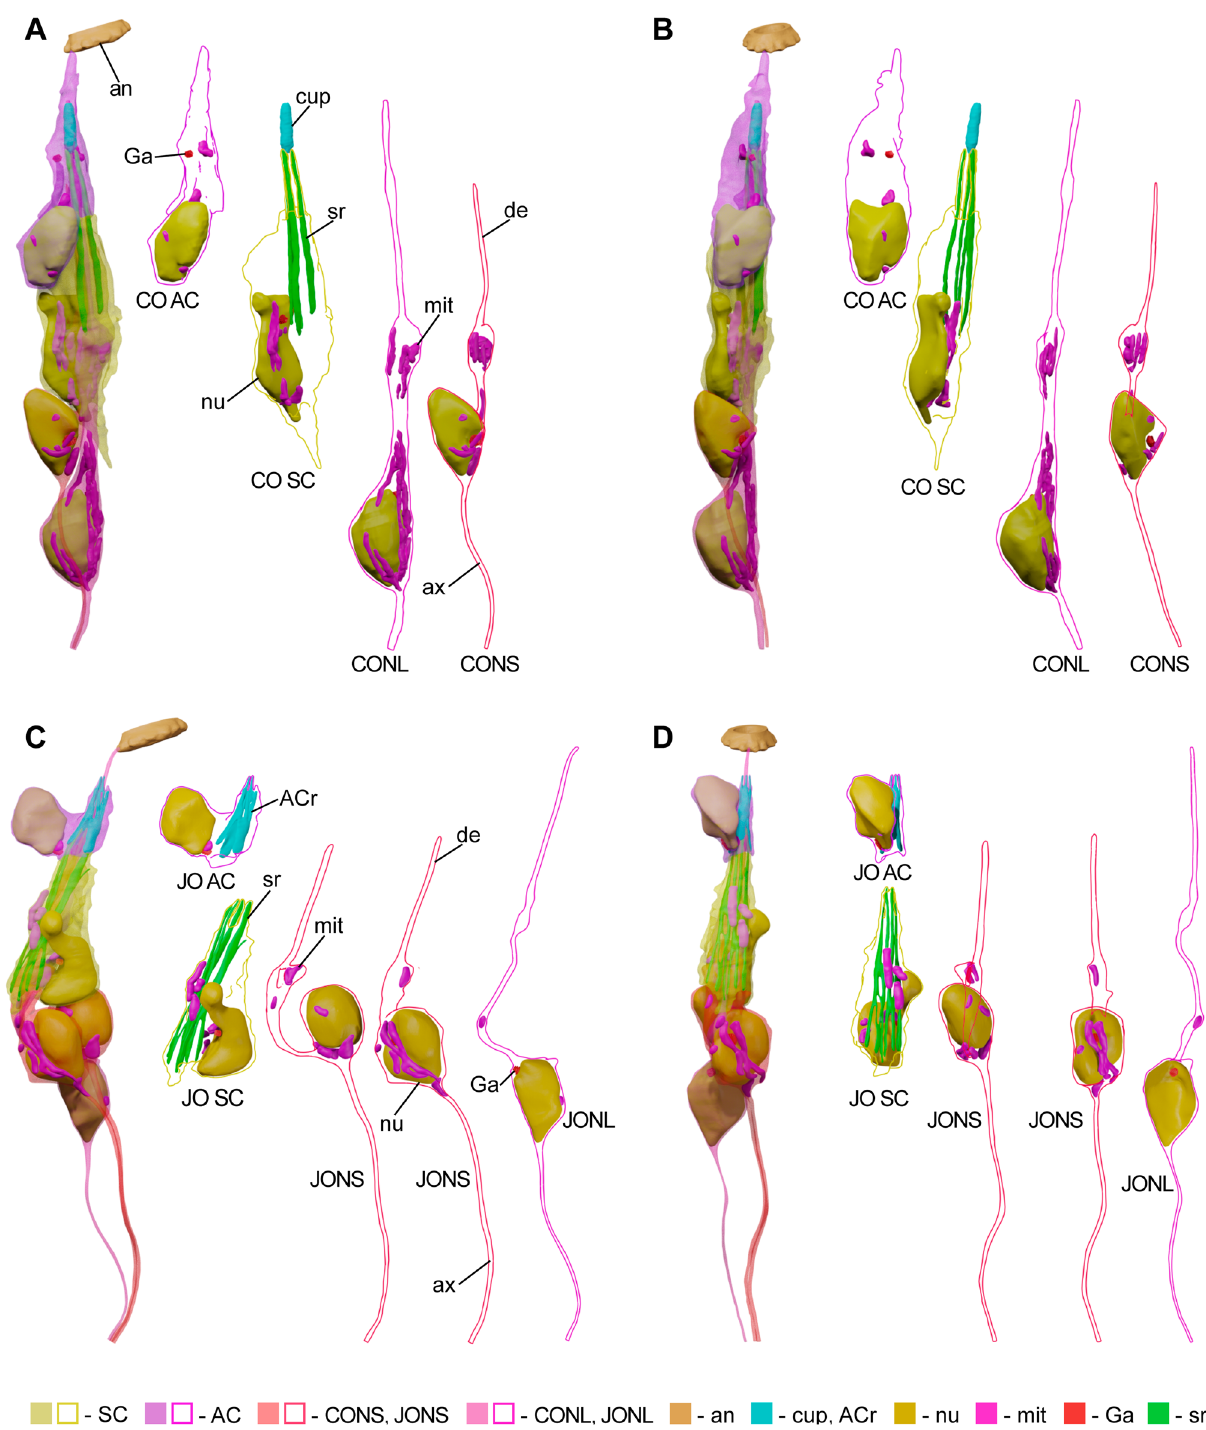
Figure 5. 3D models of M. viggianii JO and CO cells and their organelles. Each scolopidium is shown with transparent cell surfaces, subsequent images demonstrate each cell with the suface shown as an outline. ( A ), ( B ) CO scolopidium; ( C ), ( D ) JO scolopidium. (ACr—AC rods, an—annelus, ax—axon, de—dendrite, Ga—Golgi apparatus, mit—mitochondria, nu—nucleus, sr—scolopale